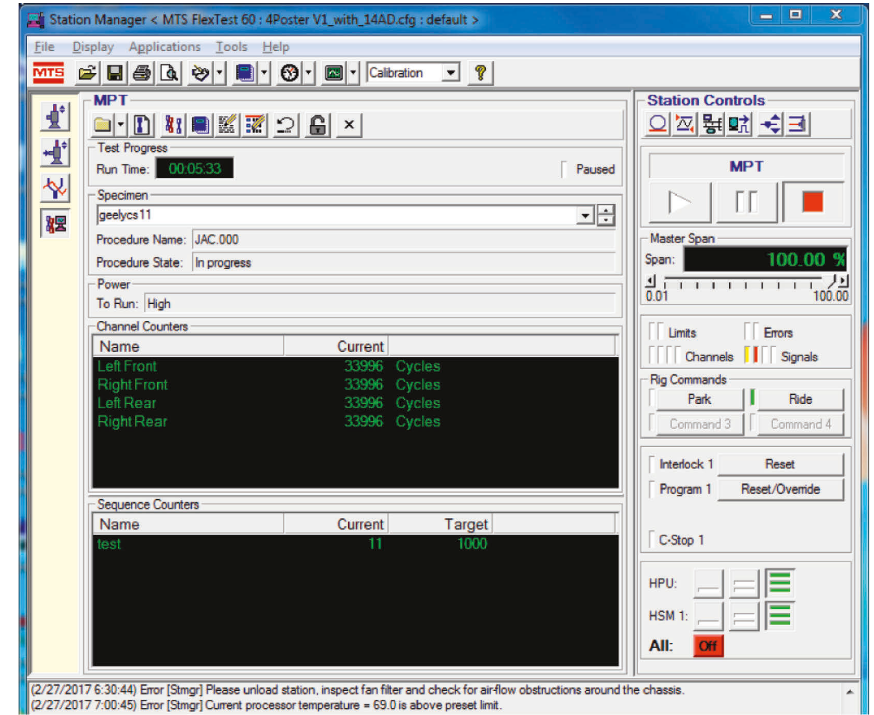
Figure 6: Interface of the basic testing